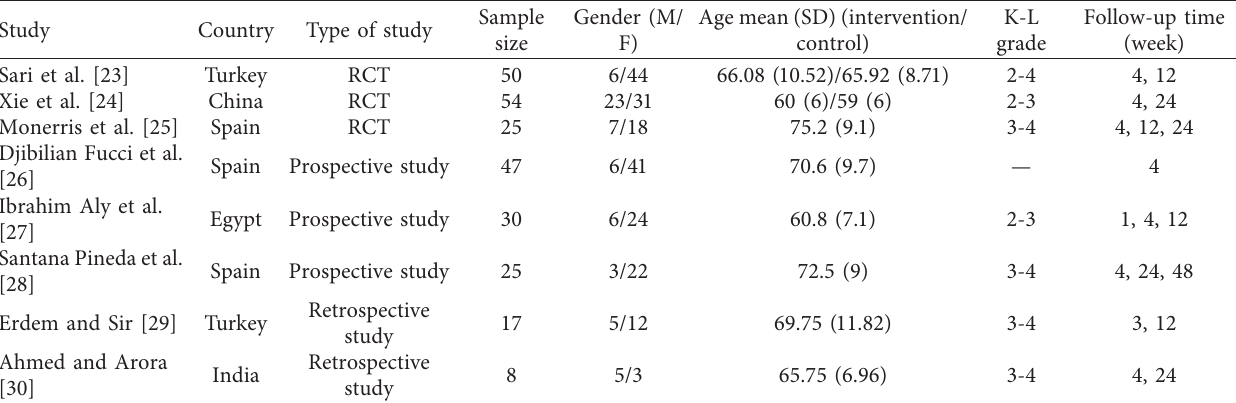
Figure 1: Flowchart of study selection. Table 1: Included